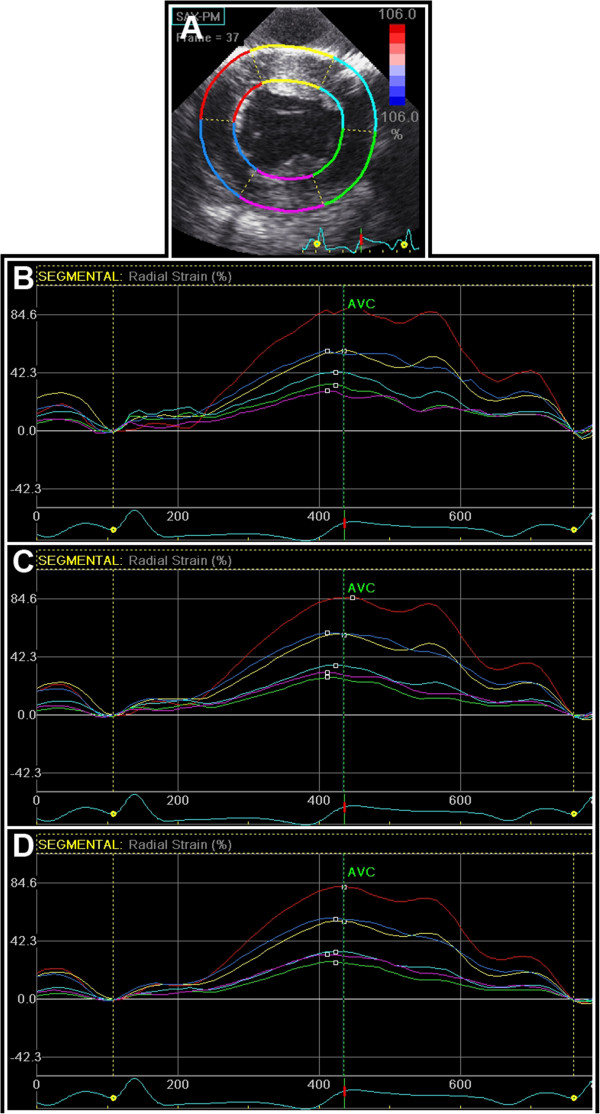
Radial strain curves with different degrees of user controlled spatial and temporal smoothing. (A) Epicardial left ventricular short-axis view used for 2-dimensional strain analysis with Speckle Tracking Echocardiography. The left ventricle is divided into 6 standard segments, labeled AntSept (yellow), Ant (cyan), Lat (green), Post (pink), Inf (blue) and Sept (red). Regional radial and circumferential strain was measured within each segment. The anterior and posterior wall was defined as the AntSept and Post segment, respectively. Global strain was calculated as the average value of the six segmental strain values at each frame throughout the heart cycle. The curves show radial strain at baseline with (B) minimal, (C) factory default and (D) maximal degrees of both spatial and temporal smoothing.